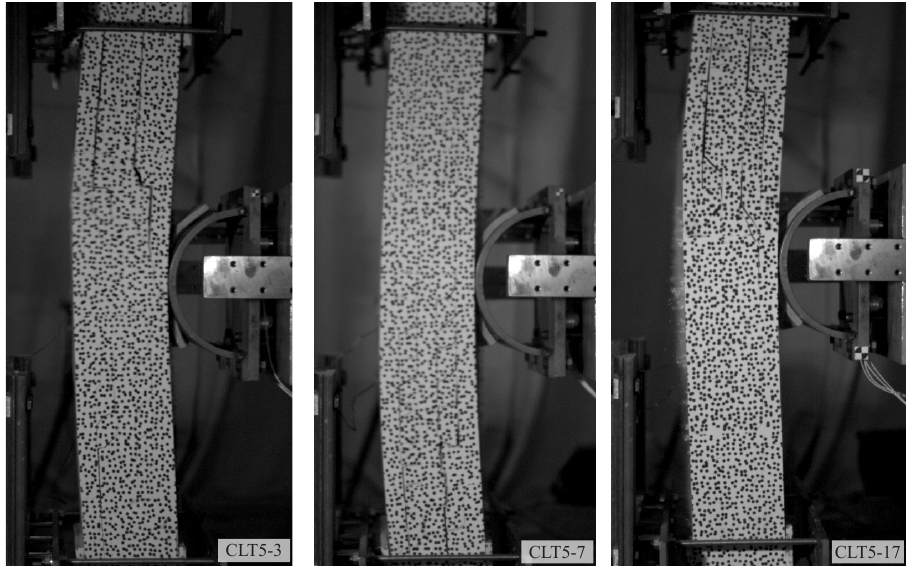
Figure 19. Comparison of damage in five-laminae clt at varied impact energies. From Left to Right: CLT5-3 ( E impact = 7.50 kJ), CLT5-7 ( E impact = 4.45 kJ), CLT5-17 ( E impact = 1.09